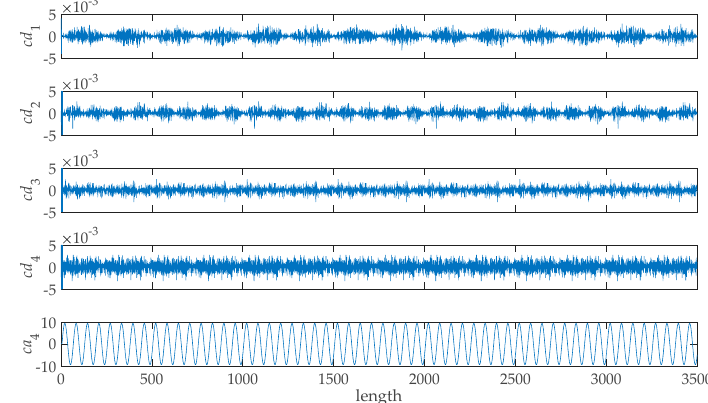
Table 5. Partial singular values of approximation coefficient